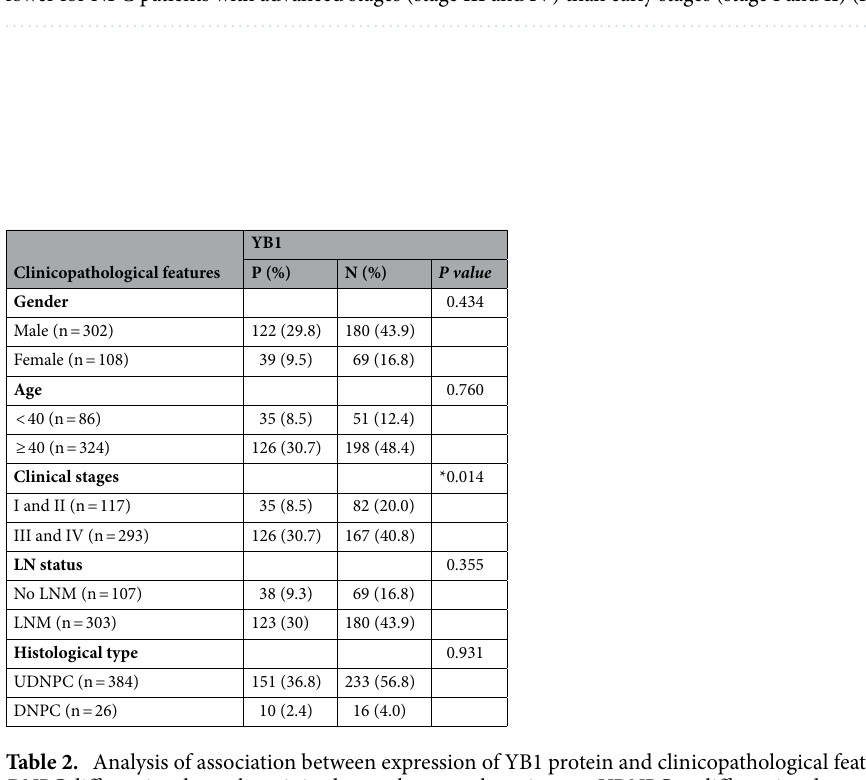
Figure 2. Expression of YB1 predicted overall survival of patients with NPC. ( A ) Strong positive expression of YB1 protein was presented in the NPC; ( B ) weak positive expression of YB1 was indicated in the columnar epithelial cells of non-cancerous nasopharyngeal tissue; ( C ) the matched IgG isotype antibody as a negative control showed no positive staining of YB1 in the NPC; ( D ) The overall survival rates were significantly lower for NPC patients with positive expression of YB1 ( P = 0.005); ( E ) the overall survival rates were significantly lower for NPC patients with lymph node metastasis ( P < 0.001); ( F ) The overall survival rates were significantly lower for NPC patients with advanced stages (stage III and IV) than early stages (stage I and II) ( P < 0.001).